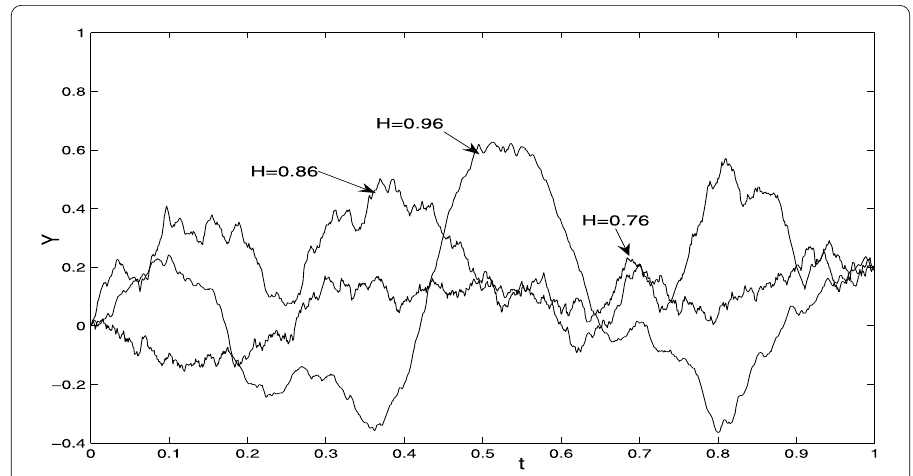
Figure 2 Sample paths of model (9) for different values of Hurst parameter (Chosen parameters a = 0.25; b = 0.45; c = 0.3)